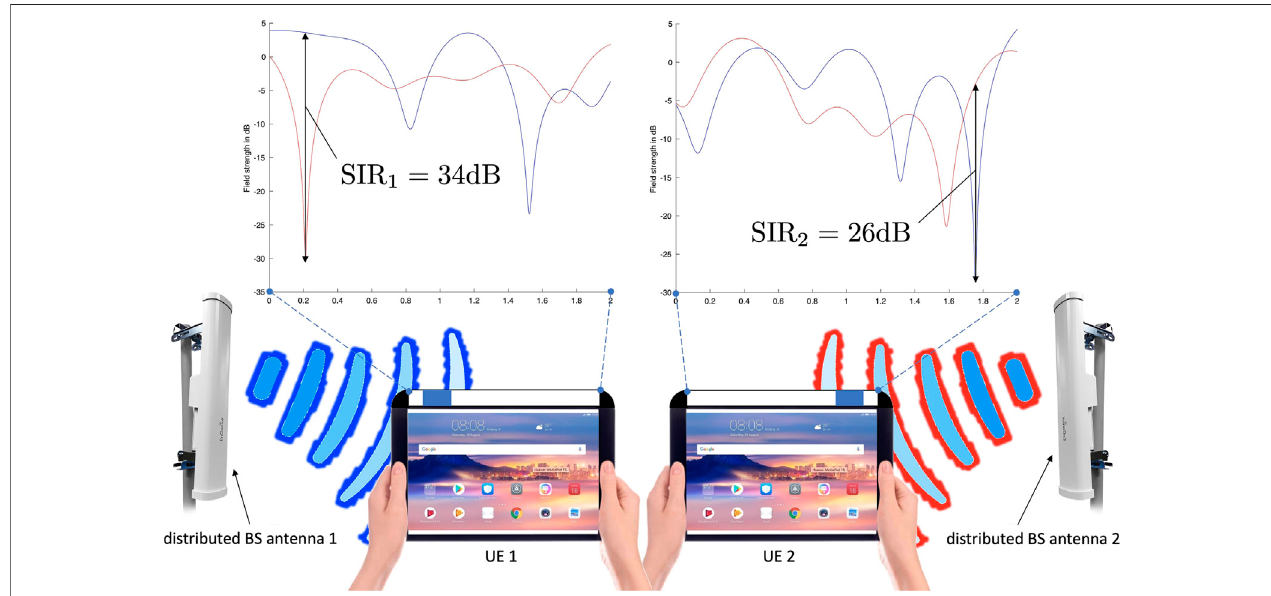
FIGURE 2 | A downlink network with the base station (BS) using distributed antennas to communicate with two fl uid antenna – aided user equipment (UE). The fadingenvelopesoftheintendedsignalandinterferenceobservedbythe fl uidantennaateachUEareshown,withanindicationthattheinterferencecansuppressitselfif the fl uid antenna chooses an appropriate port for communication, achieving multiple